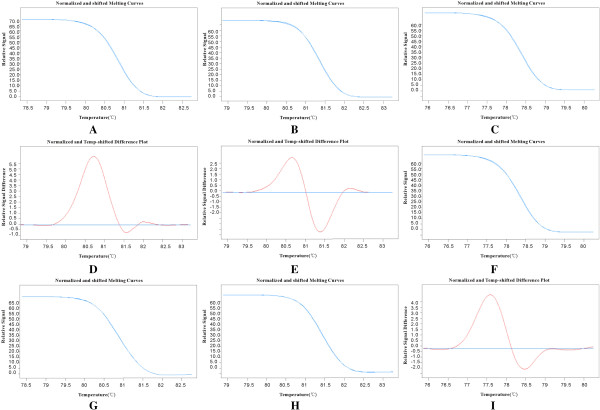
Amplification plots for PTEN mutations in exon 5,6,8 using High-resolution melting analysis. (A,B,C). Amplification plots for a sample containing no mutated in PTEN gene. A, exon 5; B, exon 6; C, exon 8. (D,E,F). Amplification plots for a sample containing mutated exon 5 and exon 6 in PTEN gene. D, exon 5; E, exon 6; F, exon 8. (G,H,I). Amplification plots for a sample containing a mutated exon 8 in PTEN gene. G, exon 5; H, exon 6; I, exon 8. The Y-axis shows the relative fluorescence for a measurement of the change in fluorescent signal versus a passive reference signal, X-axis shows the temperature (°C). Each sample was analyzed in triplicate or duplicate.